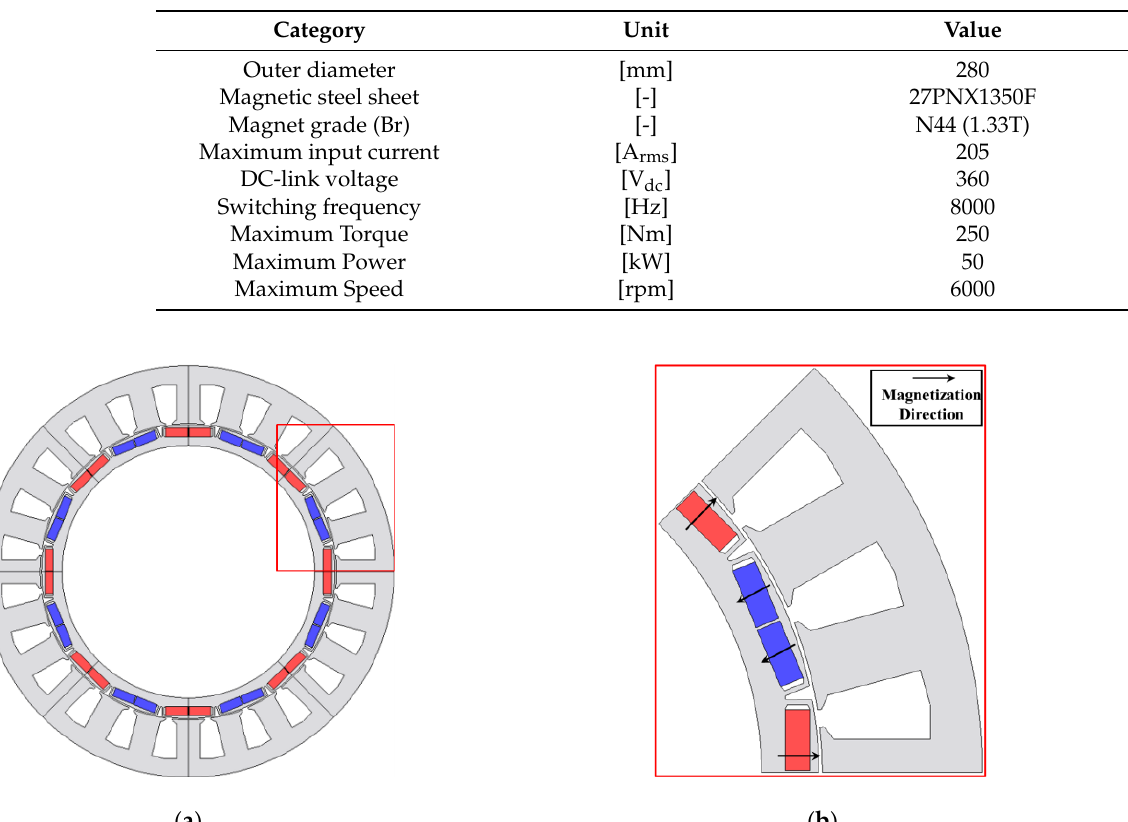
Table 1. Specifications of the target motor and inverter.